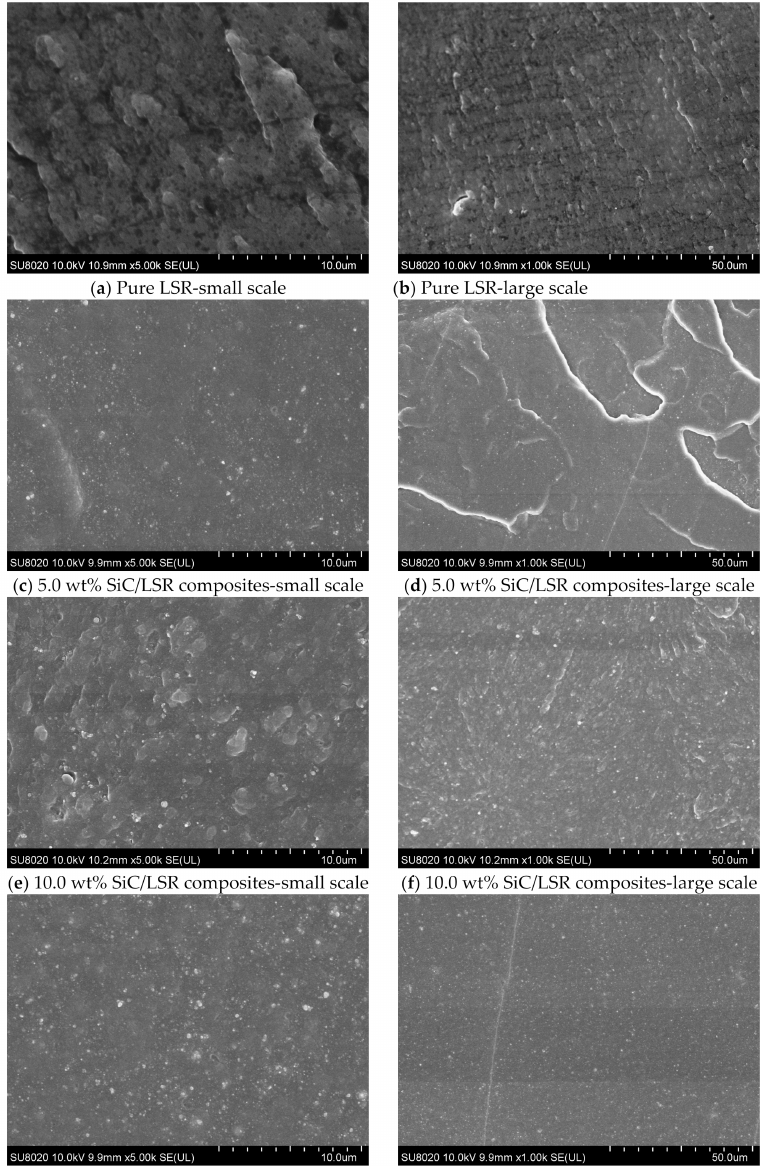
Figure 3. SEM images of SiC/LSR nanocomposites.